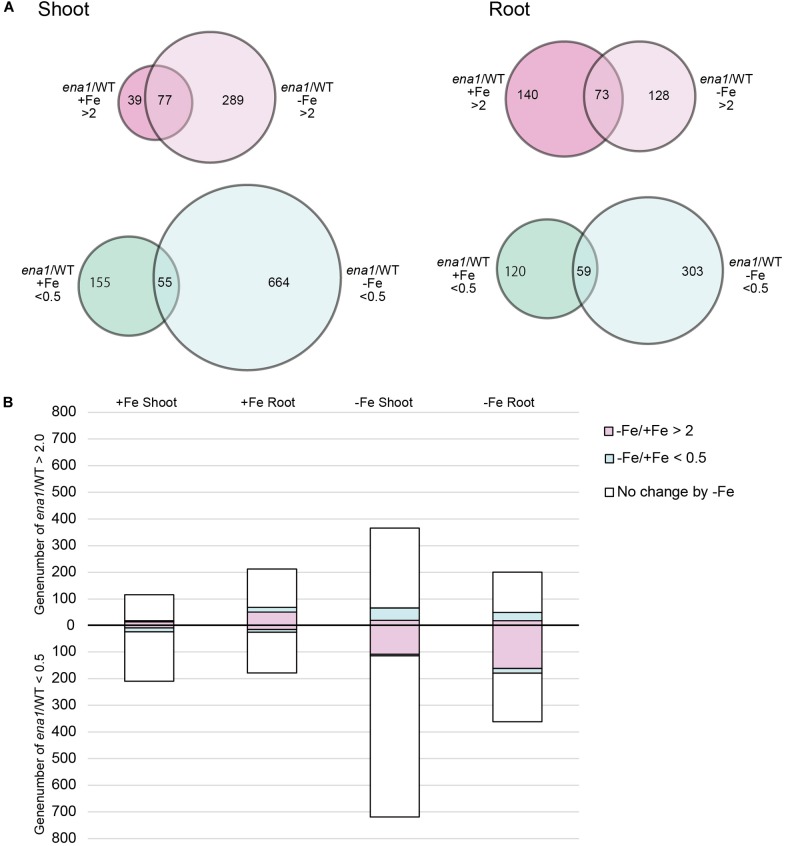
Gene expression analysis in ena1 knockout mutants and WT plants. (A) Venn diagrams represent genes differentially expressed in roots of ena1 knockout mutants compared to WT plants under Fe-sufficient or Fe-deficient conditions. Of a total of 29,864 genes, 2,102 (746 upregulated and 1,356 downregulated) were differentially expressed by at least twofold between ena1 knockout mutants compared to WT plants under both Fe-sufficient and Fe-deficient conditions compared with the gene list in Supplementary Table S2. (B) Graphs representing the numbers of Fe deficiency-responsive genes among the 2,102 genes, whose expression levels were upregulated or downregulated in ena1 knockout mutants compared to WT shoots and roots under Fe-sufficient or Fe-deficient conditions. Pink or blue colors indicate the ratios of genes that showed upregulation (–Fe/+Fe > 2) or downregulation (–Fe/+Fe < 0.5), respectively, by at least twofold under Fe-deficient conditions in the WT.